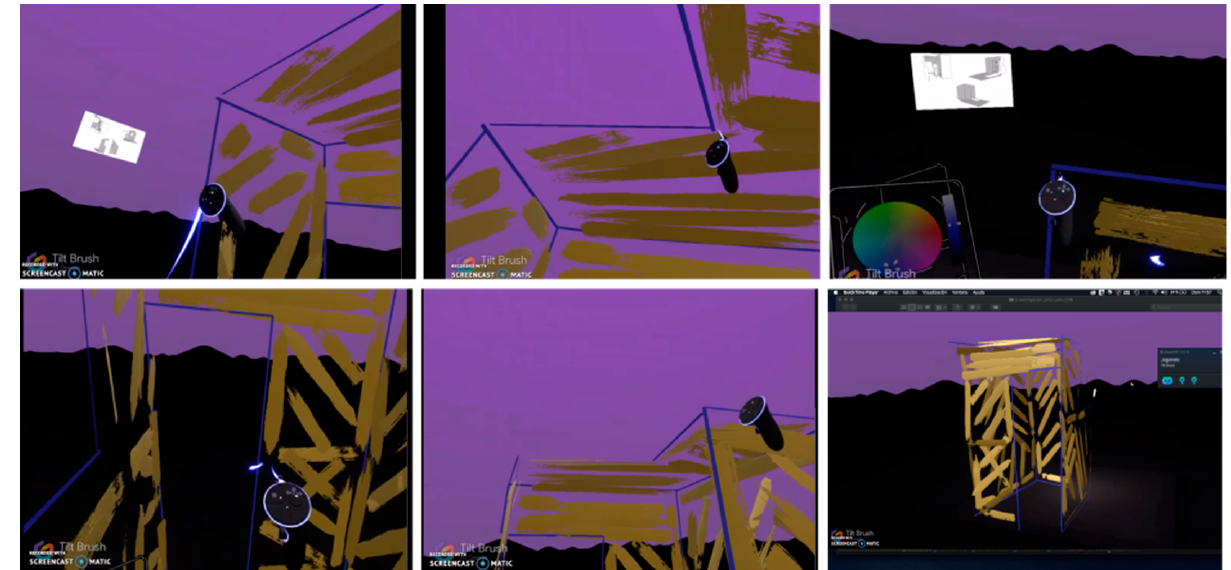
Figure 9. Scenes drawing with Tilt-Brush.